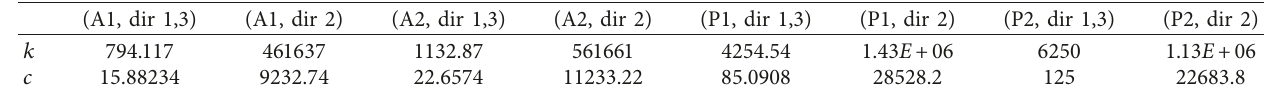
Table 3: Dashpot coefficients, c , for each abutment and pier.